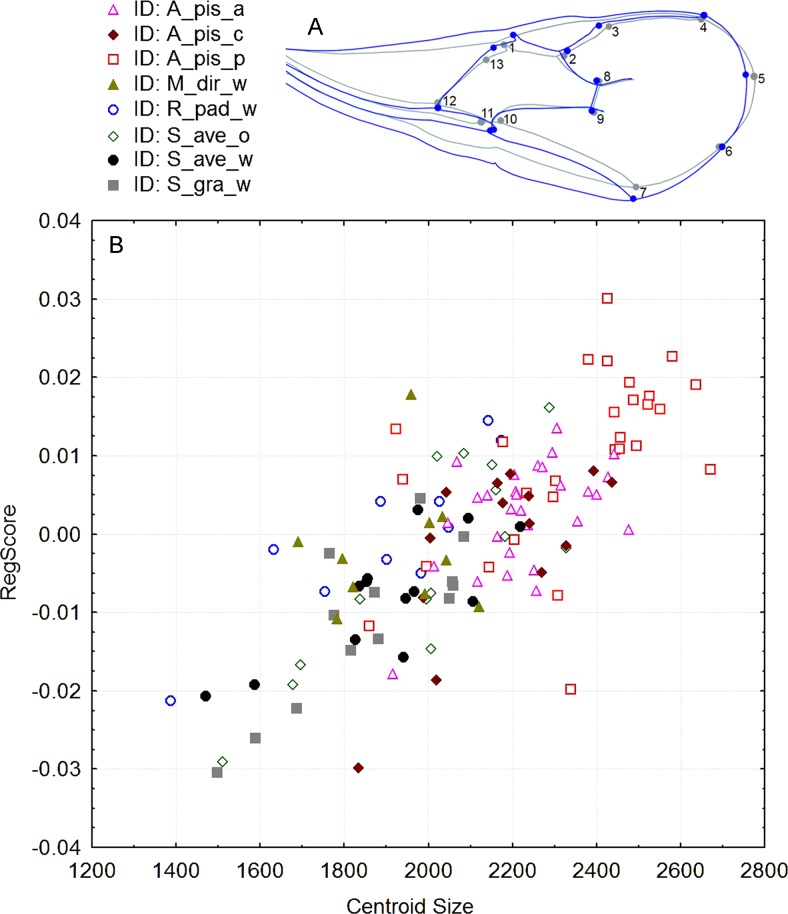
(A): Figure of forewing shape changes in A_pis_p biotype. The blue line represents the largest wing shape analyzed, while the gray line represents the average wing shape. (B): The regression results of the centroid size (CS) and PC scores (permutation test against the null hypothesis of independence, P-value: <0.0001).The included biotypes were Acyrthosiphon pisum from alfalfa (A_pis_a), A. pisum from red clover (A_pis_c), A. pisum from pea (A_pis_p), Metopolophium dirhodum from wheat (M_dir_w), Rhopalosiphum padi from wheat (R_pad_w), Sitobion avenae from oat (S_ave_o) and wheat (S_ave_w) and Schizaphis graminum from wheat (S_gra_w).